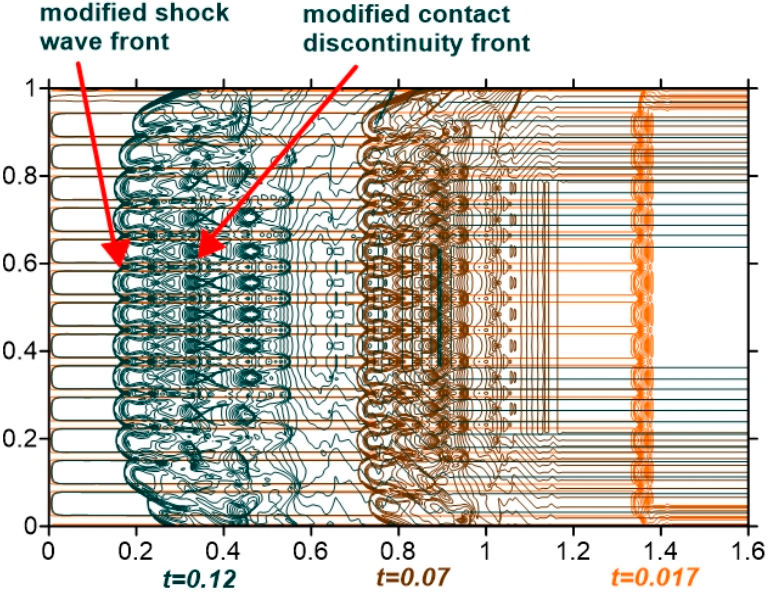
Figure 4. Dynamics of the density field in isochores: M = 8, α = 0.1, t = 0.017, 0.07 and 0.12 (super- posed).